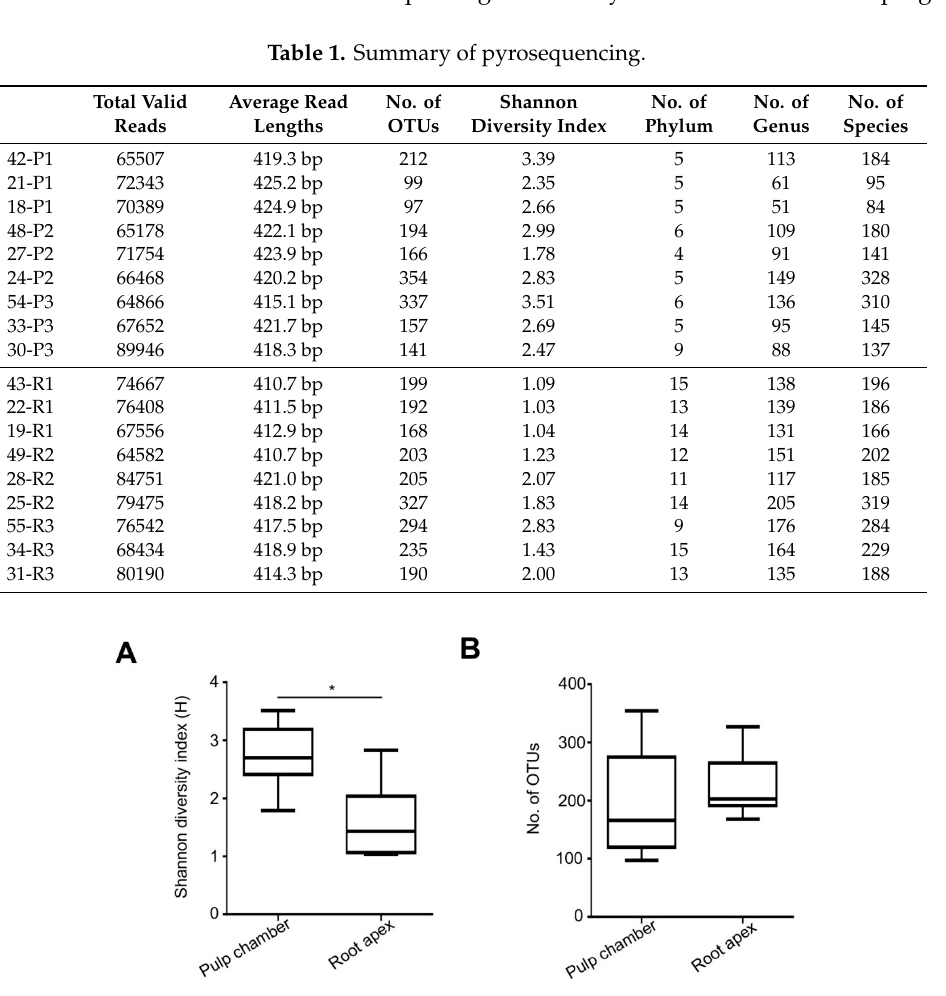
Figure 3. Diversity and species-level operational taxonomic units in the pulp chamber and the root apex. ( A ) Shannon diversity index in the pulp chamber and the root apex. Alpha diversity and Shannon diversity index are plotted for the pulp chamber and the root apex. The line inside the box indicates the median. * P < 0.05. ( B ) Species-level operational taxonomic units in the pulp chamber and the root apex. The cuto ff value for assigning a sequence to a species-level phylotype was 97% similarity. Cluster_fast command was used to conduct de novo clustering to generate operational taxonomic units